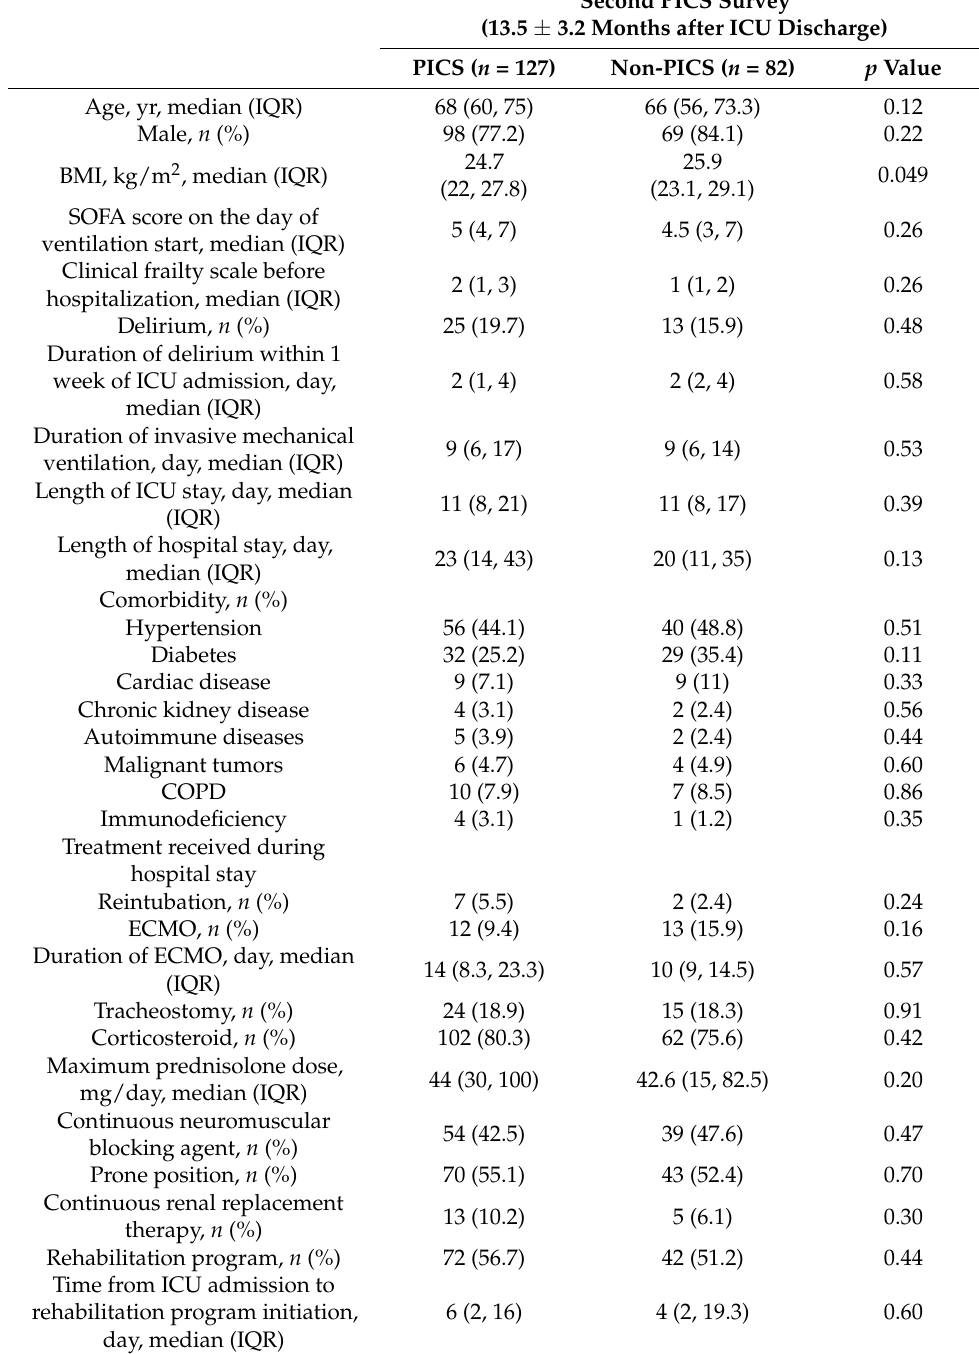
Table 2. Patient characteristics and clinical course in second PICS